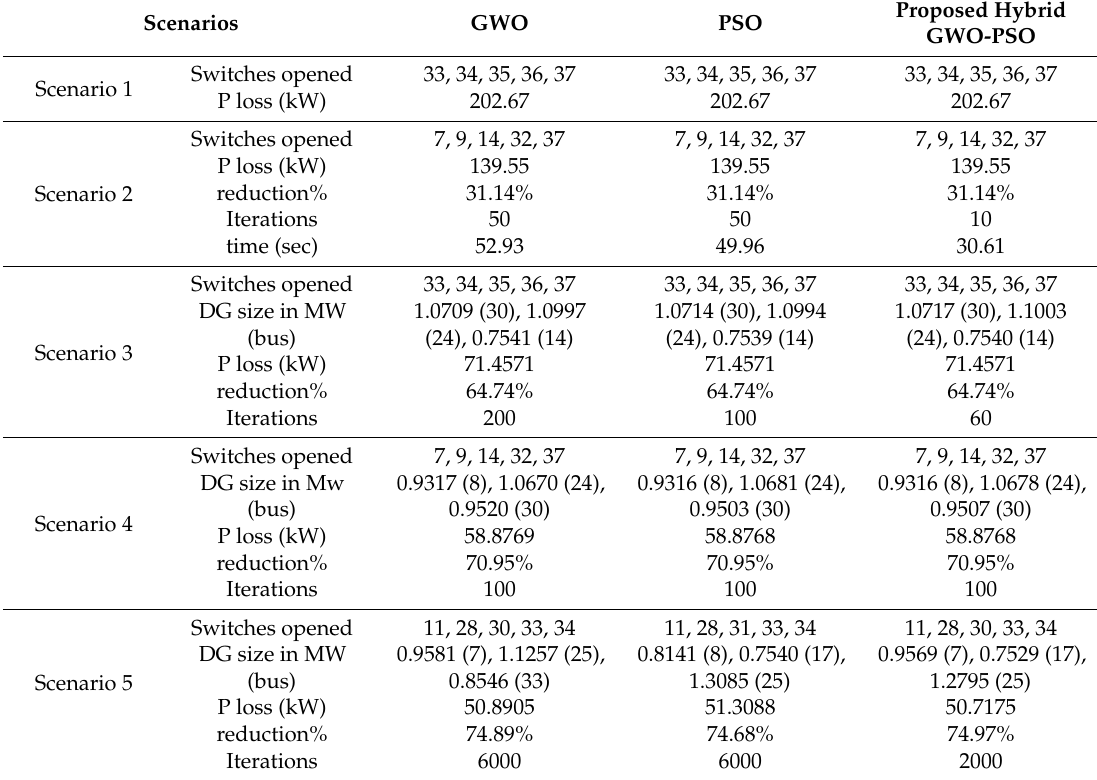
Table 2. Comparison of simulation results for P-Type DG units of a 33-bus system.